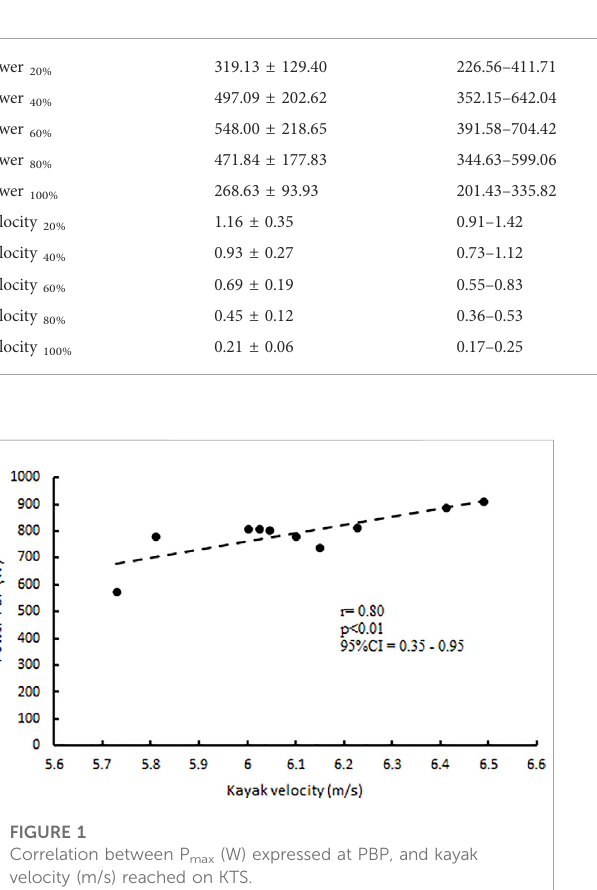
TABLE 1 Comparison between values of Power (W) and Velocity (m/s) expressed during BP and PBP. All values are mean ± SD (95% Con fi dence Interval). Signi fi cant difference (between subject) as reported for p < 0.05 (*), for p < 0.01 (**) and for p < 0.001 (***). Parameters